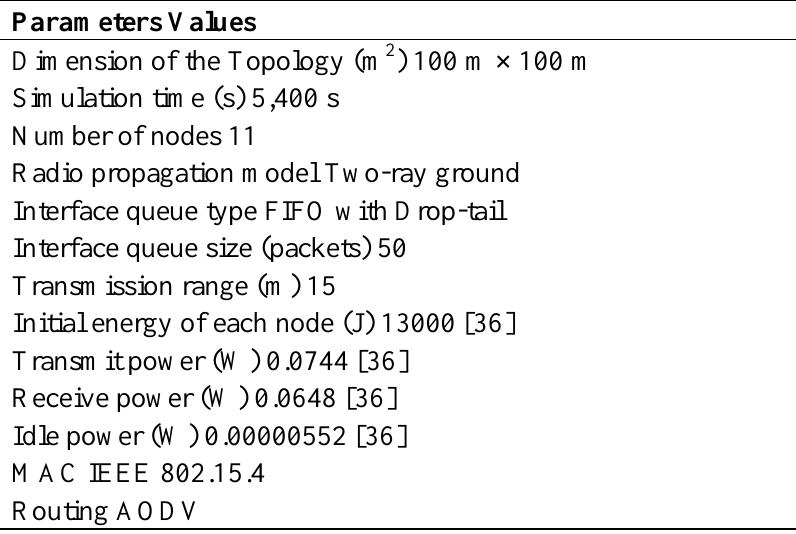
Table 2. Simulation